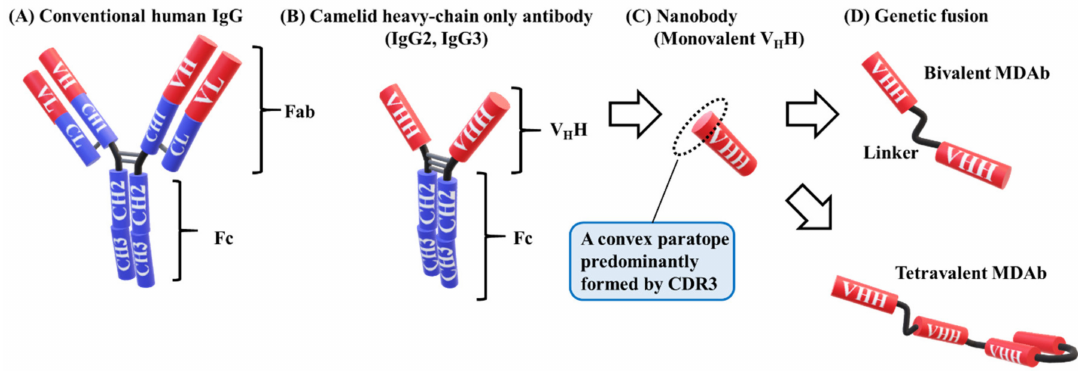
Figure 2. Model of human and camelid IgG. ( A ) Conventional human IgG consists of two identical heavy chains with one variable domain (V H ), three constant domains (C H 1, C H 2, and C H 3), and two identical light chains with one variable domain (V L ) and one constant domain (C L ). Fab contains the antigen-binding sites, and Fc is involved in e ff ector functions. ( B ) The structure of camelid IgG1 (not shown) is similar to that of human IgG. Camelid IgG2 and IgG3 lack light chains and C H 1 domains. The hinge region of IgG2 is longer than that of IgG3 (the model is representative) [85]. ( C ) V H H, known as a nanobody, consists of a variable domain of camelid IgG (IgG2 or IgG3) and forms a paratope with a single domain. The molecular weight is approximately 15 kDa. A convex paratope is predominantly formed by the CDR3 loop to bind to clefts or pockets of the antigen. ( D ) V H H is easily modified via genetic multimerization to a bivalent or tetravalent multidomain antibody (MDAb).